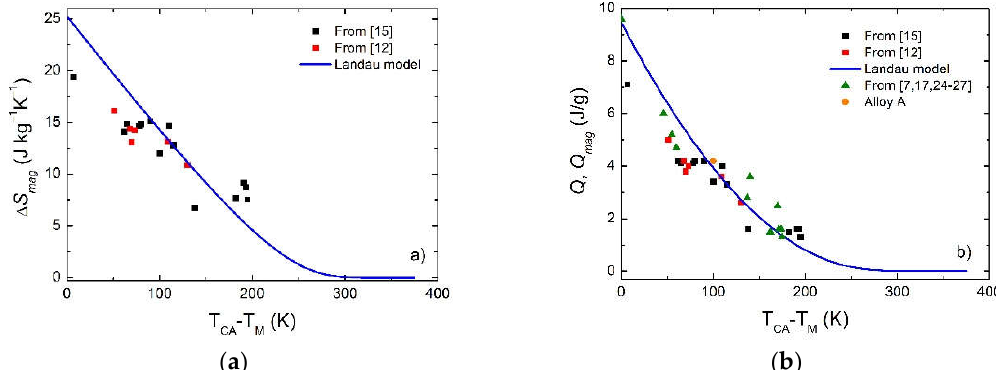
Figure 2. ( a ) Calculated magnetic entropy change versus T CA – T M (solid line) and complete entropy changes (symbols) measured for different Ni‐Mn‐Ga alloys. ( b ) Calculated magnetic contribution to the transformation heat versus T C – T M (solid line) and transformation heats (symbols) measured for different Ni‐Mn‐Ga alloys.